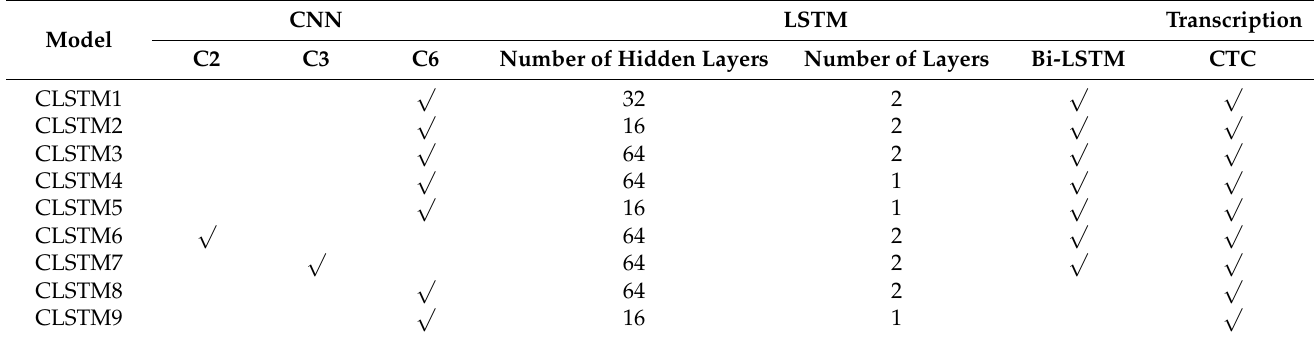
Table 2. Nine end-to-end models are composed of different network architectures.